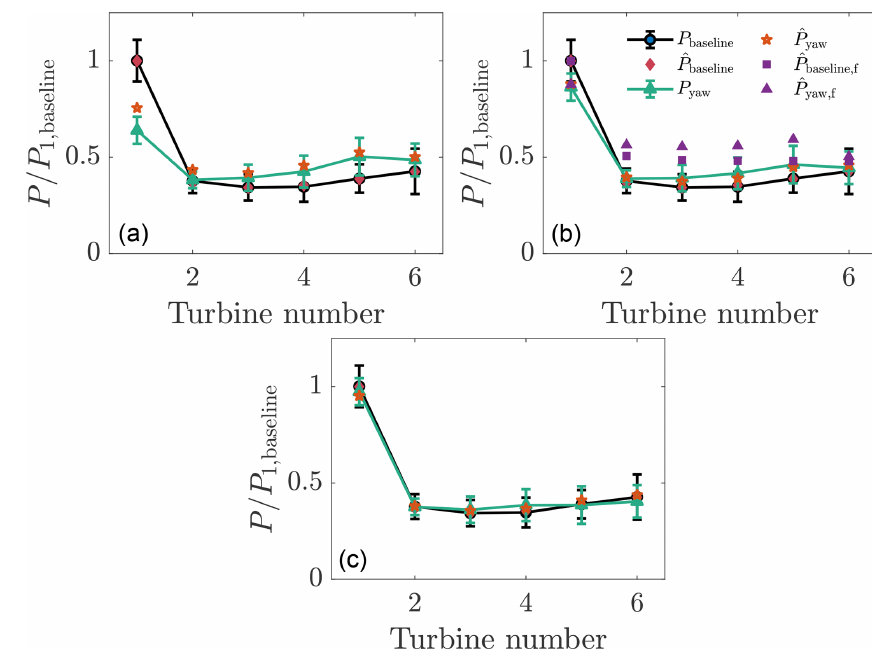
Figure 21. Wind turbine power production from LES P and wake model ˆ P . P 1 , baseline is the LES power production for the leading upwind turbine from control update step 1 where the wind farm is operated with the greedy baseline control. ˆ P baseline is the wake model fit to P baseline using EnKF estimation. P yaw is the LES power production for control update step 2 with yaw misalignment incorporated. ˆ P yaw is the wake model prediction of P yaw using k w and σ 0 fit based on control update step 1 and with the optimal yaw misalignment angles which were implemented by control update step 1. The wake model estimate for P p , given by ˆ P p , is (a) ˆ P p = 2, (b) ˆ P p = 3, and (c) ˆ P p = 4. The error bars represent 1 standard deviation in the power data as a function of time. The subscript “f” denotes power predictions from the FLORIS wake model (Annoni et al., 2018) with the Gaussian wake model (Bastankhah and Porté-Agel, 2014) and model parameters prescribed by Niayifar and Porté-Agel